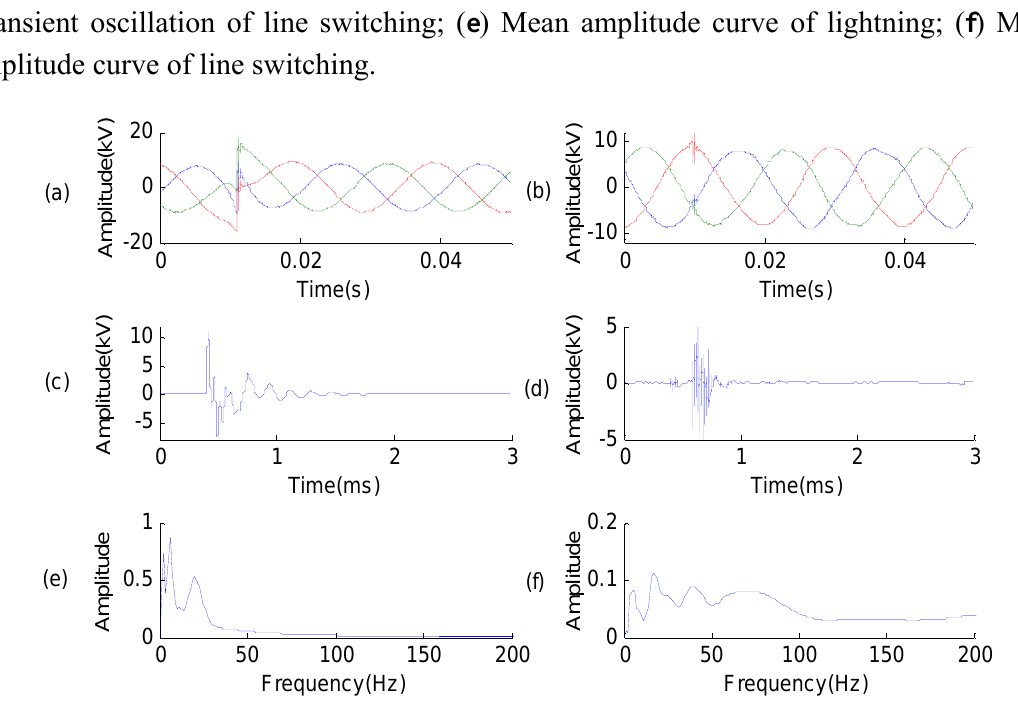
Benefiting from the unique sampling model of over-voltage monitoring devices in this paper, the initial part of the over-voltage waveform is sampled at 5 MHz. Therefore the high frequency oscillation can be represented in detail through the discrete data (Figures 8c,d). It is clear that the transient oscillation’s frequency of line switching is higher than lightning. Figures 8e, f are the mean amplitude curves of the transient oscillation of lightning and line switching (Figures